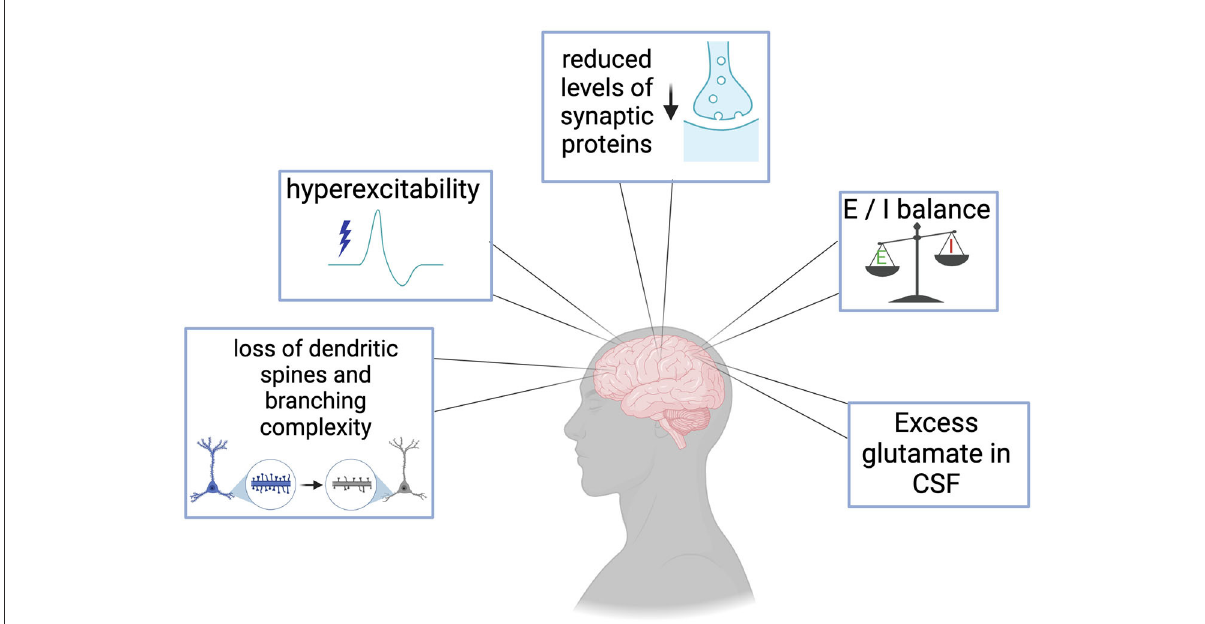
FIGURE1 Clinical manifestations and postmortem evidence of synaptic dysfunction in ALS and FTD include loss of dendritic spines and branching complexity in cortical regions, cortical hyperexcitability prior to the loss of motor neurons, reduction in essential synaptic proteins such as SV2a, imbalances in excitatory and inhibitory systems, and excess glutamate in patient cerebrospinal fluid